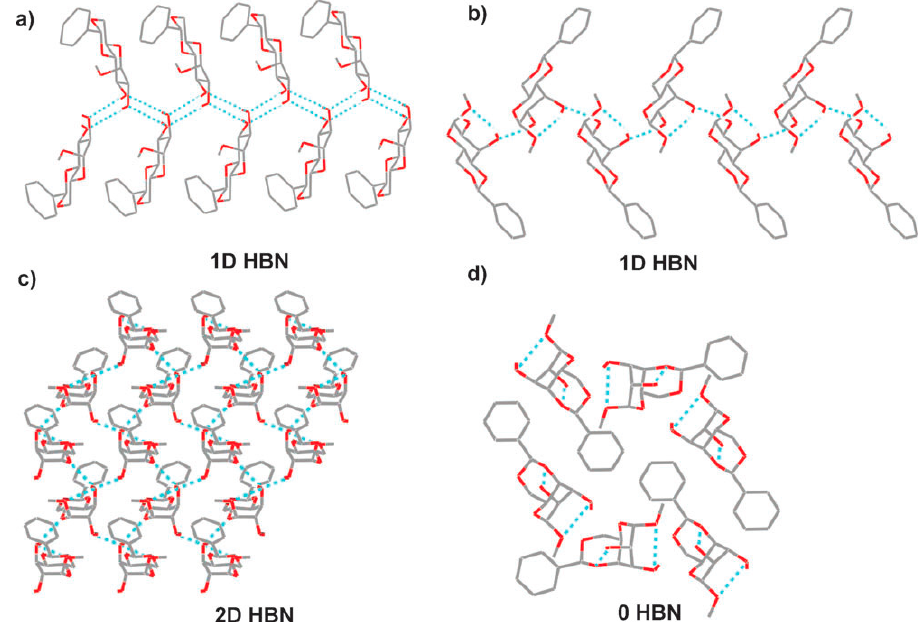
Figure 1. Crystal structure illustration of ( a ) G1, ( b ) NG2, ( c ) NG3, and ( d ) NG4 (figures were generated from CIF files retrieved from CSD 5.28, November 2006). HBN: hydrogen bonding network. (CIF: Crystallographic Information File; CSD: Cambridge Structural Database)